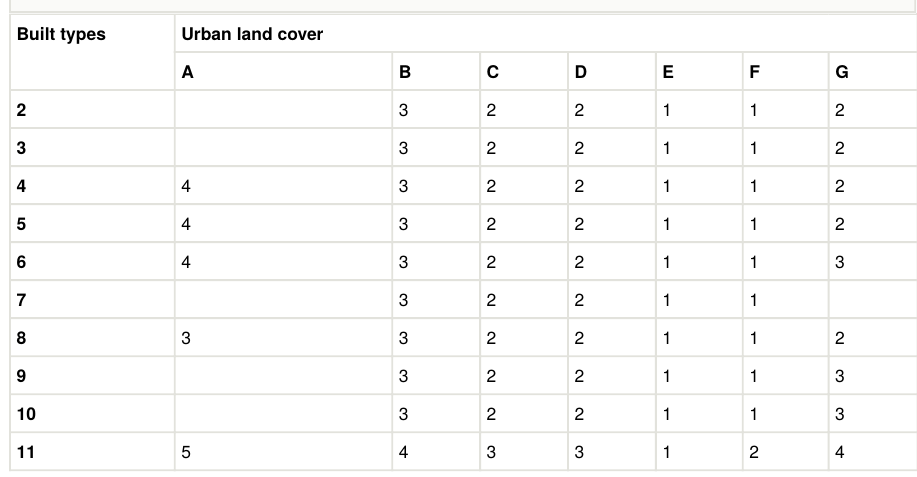
Table 3. Expert assessment scores of the urban ecosystem condition as a combination of built types and urban land cover (built type and land cover codes are given in Table 2; built type 1 not presented in the